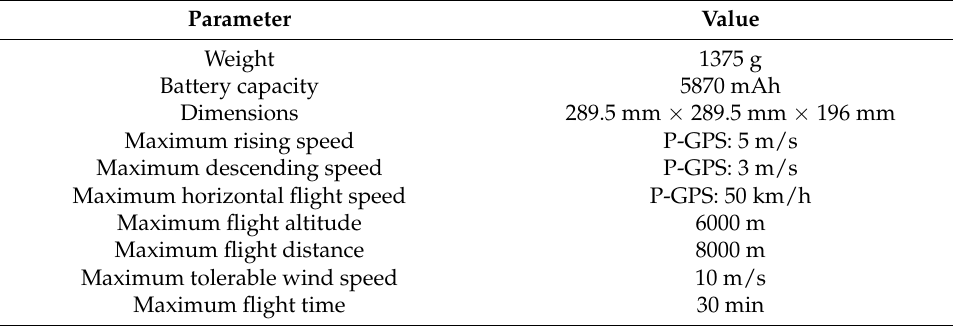
Table 1. The key parameters of phantom 4 Pro V2.0